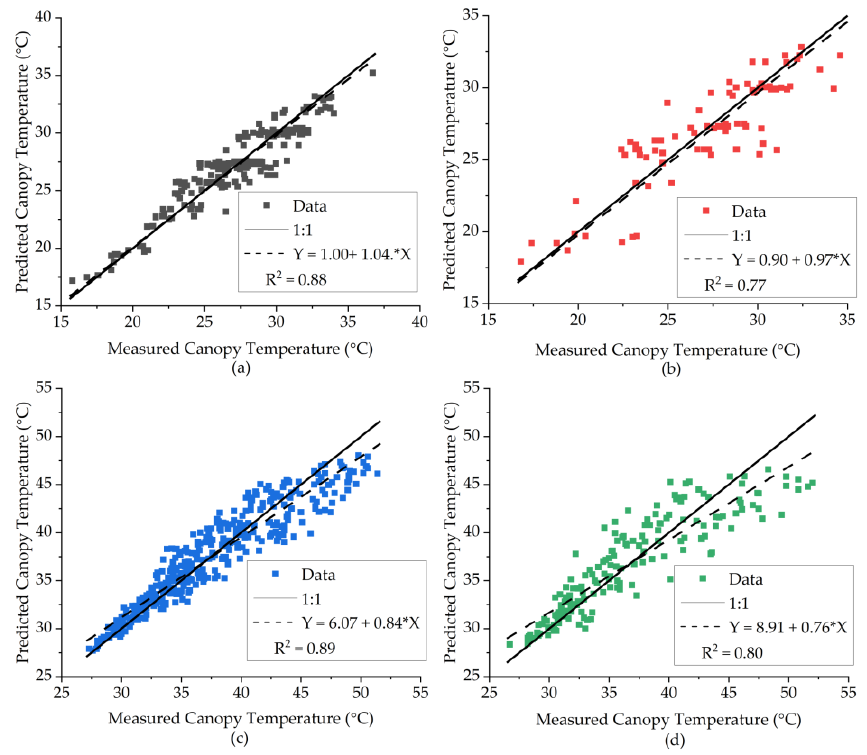
Figure 10. The performance of the model in predicting 𝑇 𝑑𝑟𝑦 in terms of the ( a ) development and ( b ) validation in E1 and the ( c ) development and ( d ) validation in E2. The variation in the prediction error for 𝑇 𝑤𝑒𝑡 and 𝑇 𝑑𝑟𝑦 is presented in Figure 11. The error was taken as the predicted value minus the measured value. The mean values of the prediction error for 𝑇 𝑤𝑒𝑡 and 𝑇 𝑑𝑟𝑦 were 0.07 and 0.10 °C for development and 0.18 and 0.22 °C for validation in E1, whereas they were 0.05 and 0.09 ° C for development and 0.11 and 0.21 °C for validation in E2. The average prediction error values for the eight models were greater than zero, displaying a positive bias between measurement and prediction. It was observed that the error variance of 𝑇 𝑤𝑒𝑡 was less than that of 𝑇 𝑑𝑟𝑦 for both models in E1 and E2. There was little difference in bias between E1 and E2 for 𝑇 𝑤𝑒𝑡 and 𝑇 𝑑𝑟𝑦 . Further- more, the range of prediction errors for validation was slightly wider than that for devel- opment, resulting in a larger RMSE value. In conclusion, the results show that the accu- racy of estimating 𝑇 𝑤𝑒𝑡 was better than that of 𝑇 𝑑𝑟𝑦 for both models in E1 and E2.